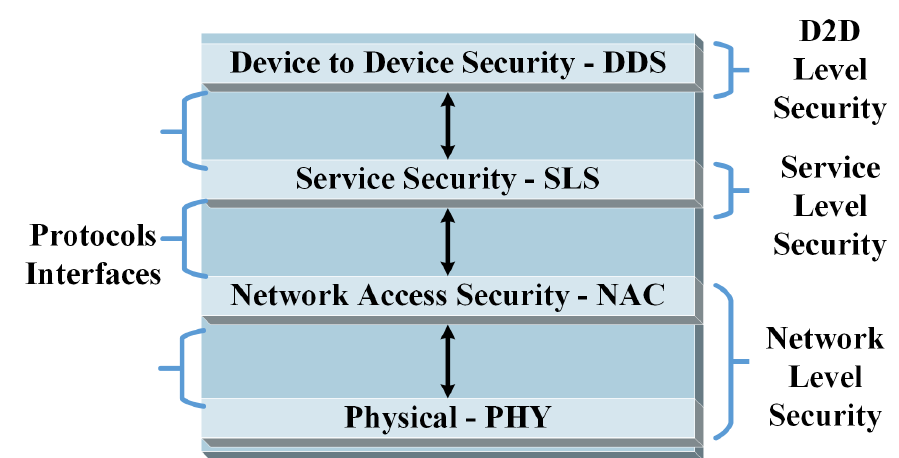
Figure 5. Interface of the Security Protocols.